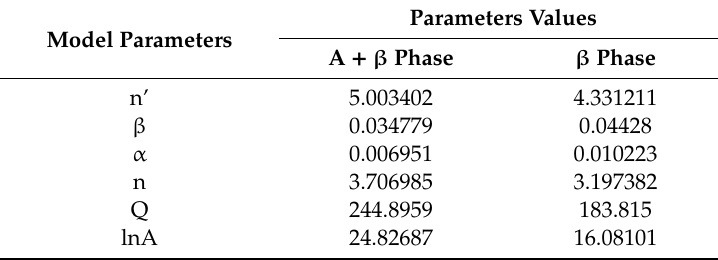
Figure 3. The relationships of ( a ) lnσ and ln𝜀(cid:4662) ; ( b ) σ and ln𝜀(cid:4662) . Table 2. Constitutive model parameters for Ti-6554